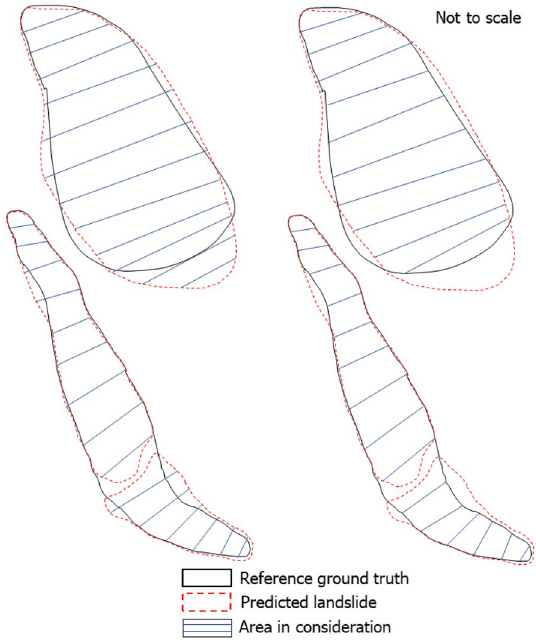
Figure 16. Example of the predicted landslide area versus the reference landslide area (left) and predicted landslide area within the reference landslide body versus the reference landslide area